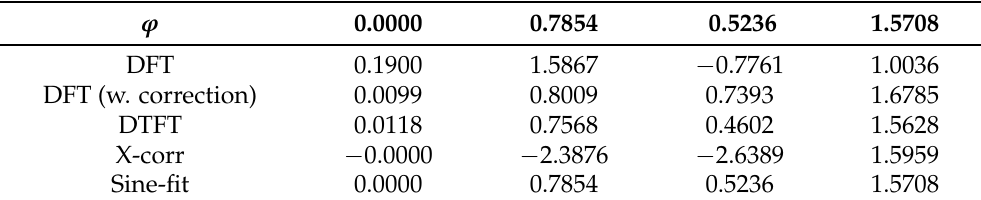
Table 11. Phase results returned by AC signal analysis algorithms for the considered test scenario.